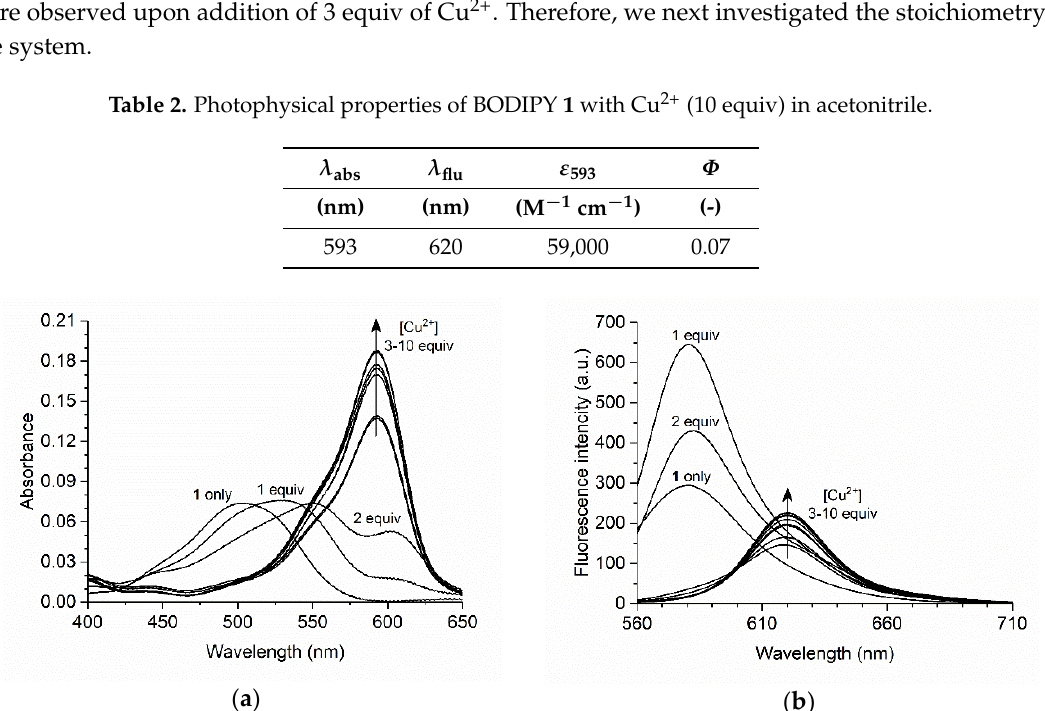
Figure 4. Changes in ( a ) absorption and ( b ) fluorescence spectra of BODIPY 1 (3 µM) with